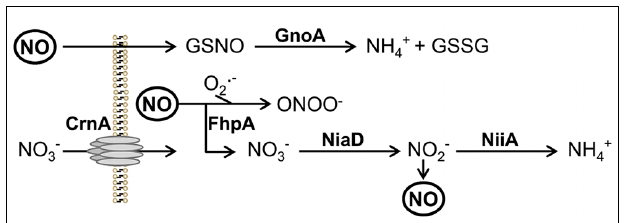
FIGURE 1 | Scheme of NO − 3 reduction and NO detoxification. Protein names are written in bold. Abbreviations: GSNO, nitrosylated glutathione; GSSG, reduced glutathione; ONOO − , peroxynitrite; O •− 2 , superoxide anion. NO, nitric oxide; NiaD, nitrate reductase; NiiA, nitrite reductase; CrnA, nitrate